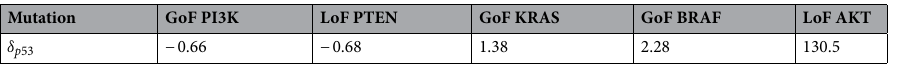
Table 1. Relative difference δ p 53 of the equilibrium concentrations of p53 induced by a set of single-gene mutations. The first and second rows report the considered mutation and the corresponding value of δ p 53 , respectively.